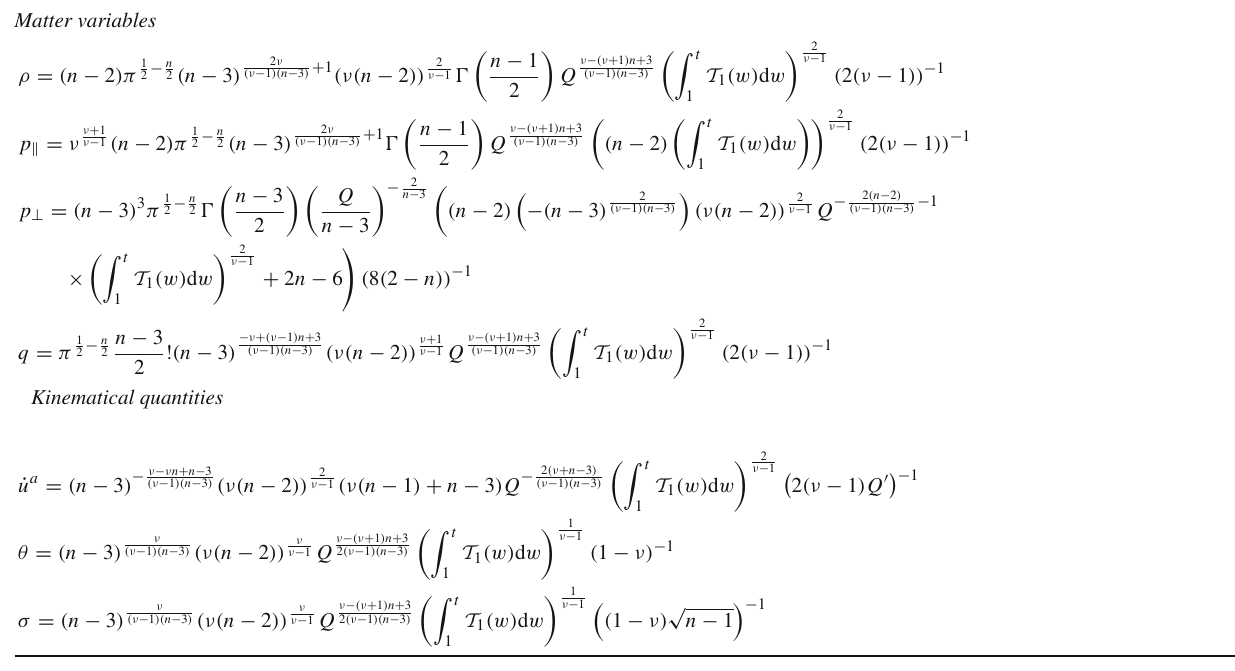
Table 1 Physical features for the boundary condition with an equation of state p (cid:3) = νρ for Model I Matter